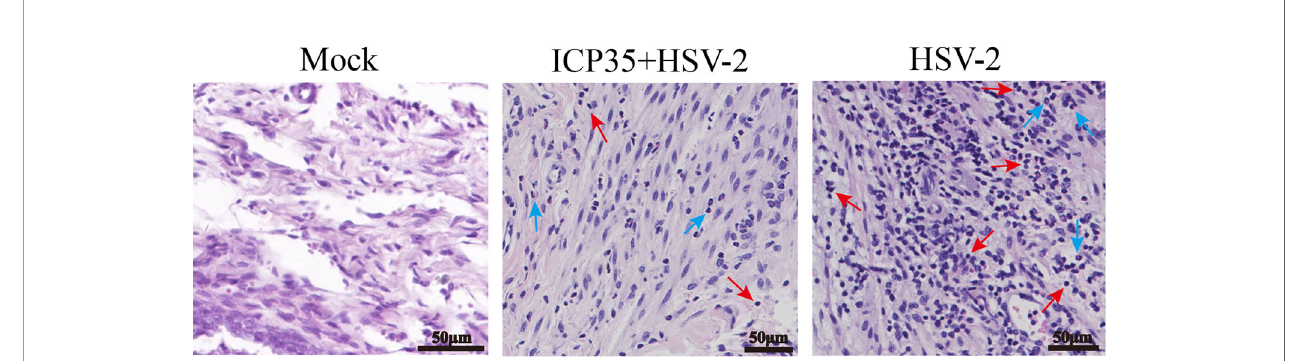
FIGURE 6 | The resulting pathological damage in various tissues of the ICP35 protein-immunized or control mice. Histopathological observation of vaginal epithelial tissue from the PBS negative control (Mock), immunized with ICP35 (ICP35+HSV-2) and immunized with Al (OH) 3 adjuvant mice (HSV-2) after viral challenge. In fl ammatory cell in fi ltration (red arrow: lymphocytes, blue